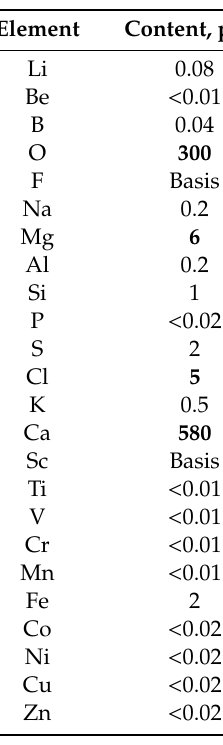
Table 1. Results of chemical analysis of ScF 3